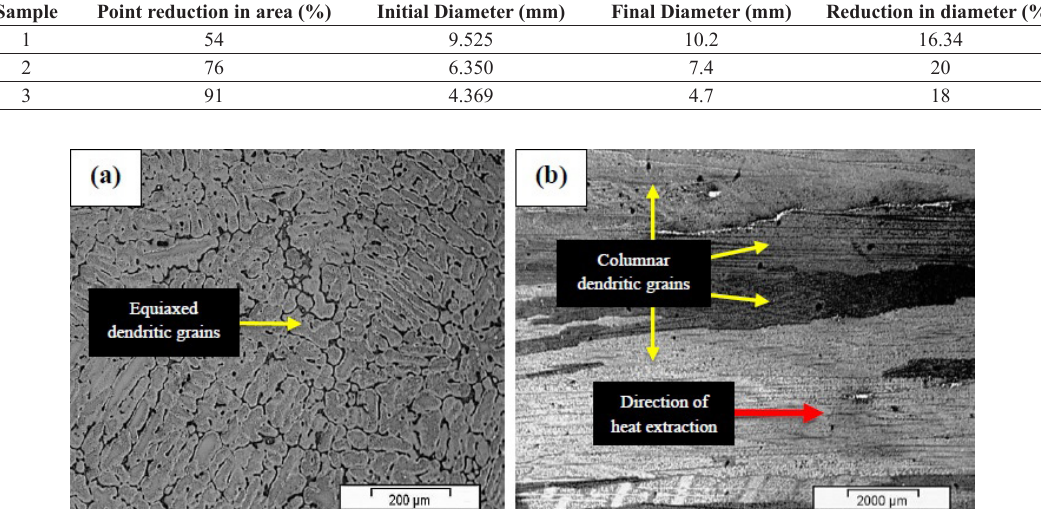
Table 1. Parameters used in the rotary swaging process. Sample